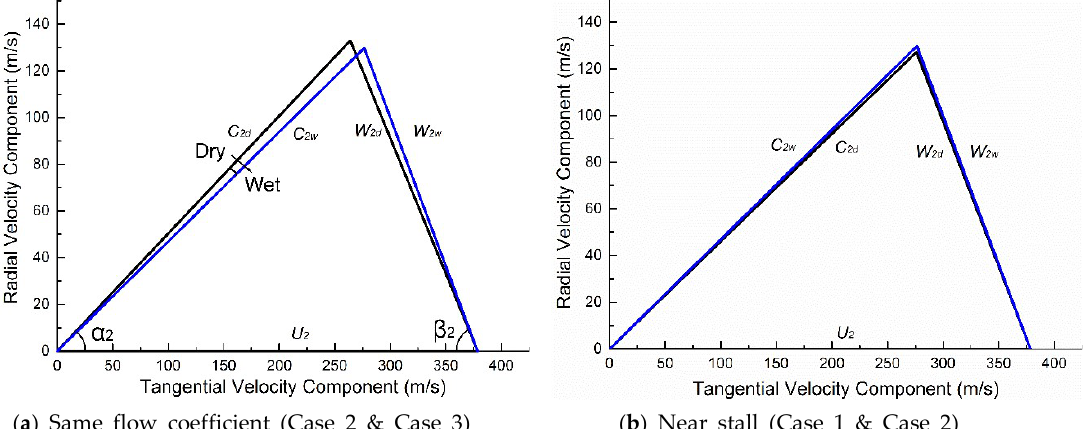
Figure 15. Comparison of the impeller outlet velocity triangles